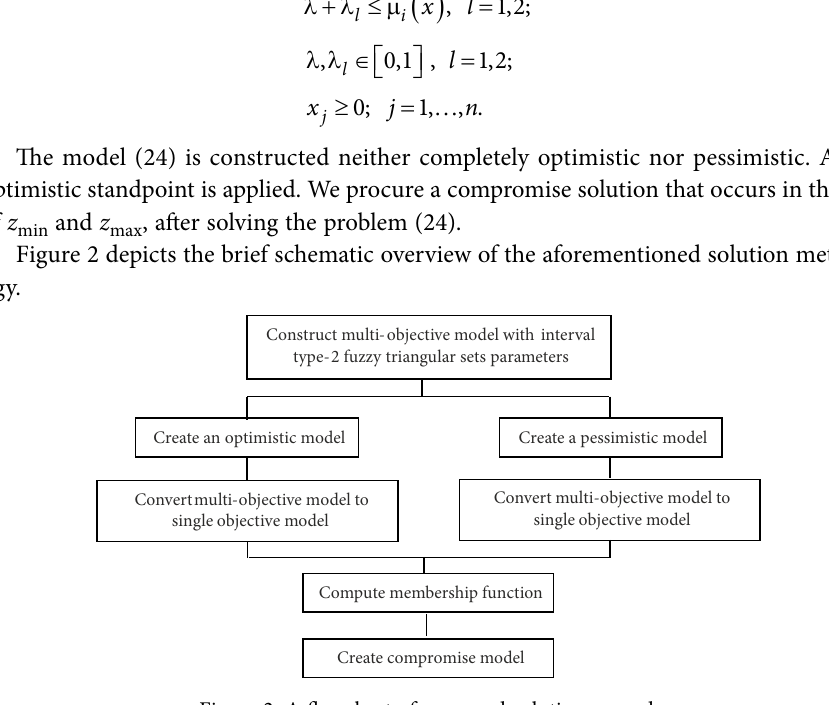
Figure 2. A flowchart of proposed solution